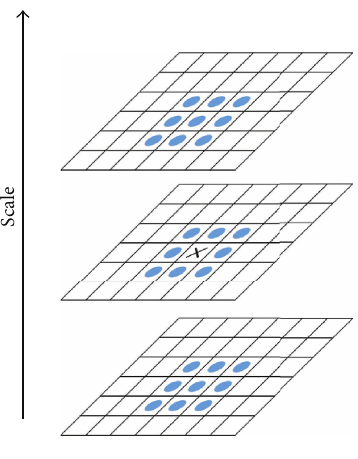
Figure 3: Key point localization.